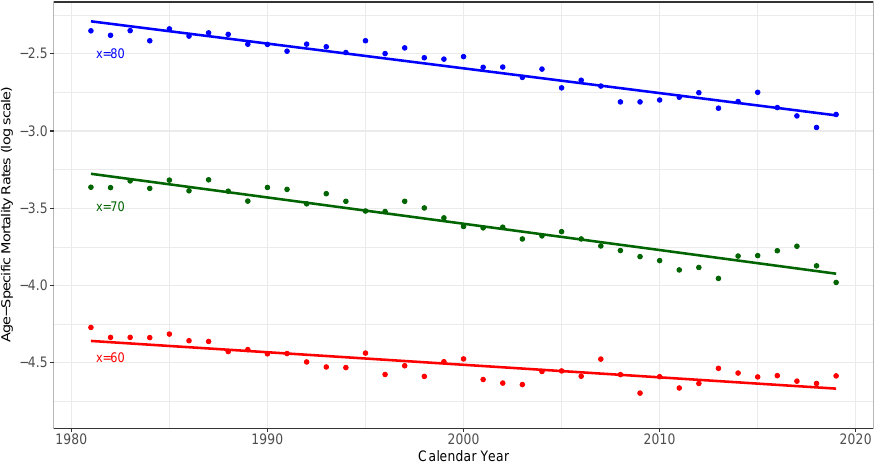
Figure 2. Observed log m ( t , x ) values of males in Greece, for ages 60, 70, 80, over the period 1981–2019. The straight lines denote the trend in mortality decline.